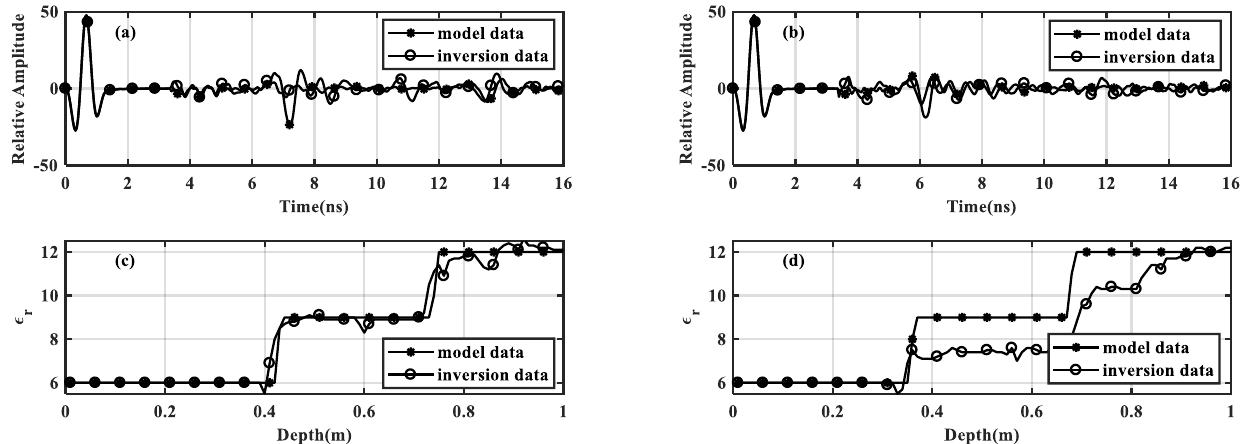
Figure 8. Comparison of the model data and inversion data regarding the relative amplitude and dielectric permittivity: ( a , c ) for the 13th trace; ( b , d ) for the 45th trace.